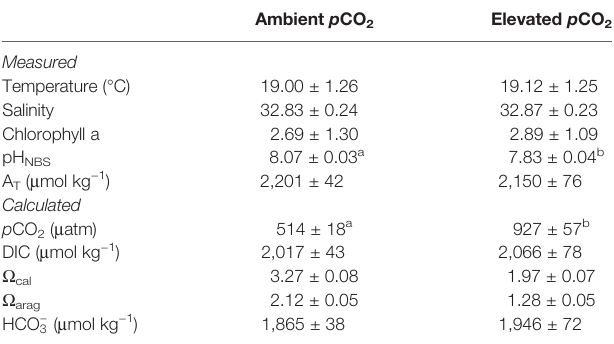
TABLE 1 | Seawater chemistry variables over the 30 days experimental period for each p CO 2 treatment.